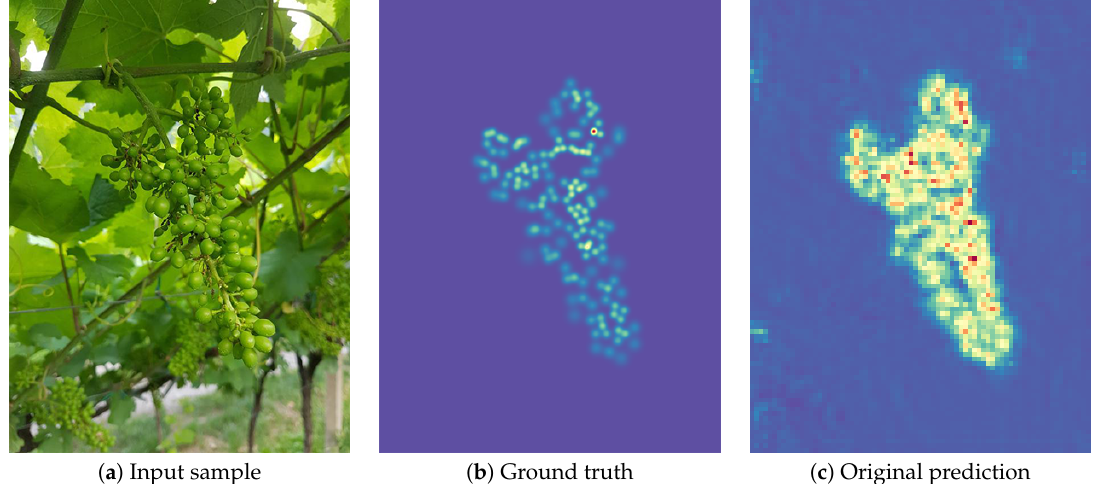
Figure 4. Example of application of GBCNet on a CR1 image ( a ), its associated ground truth ( b ) and model output ( c